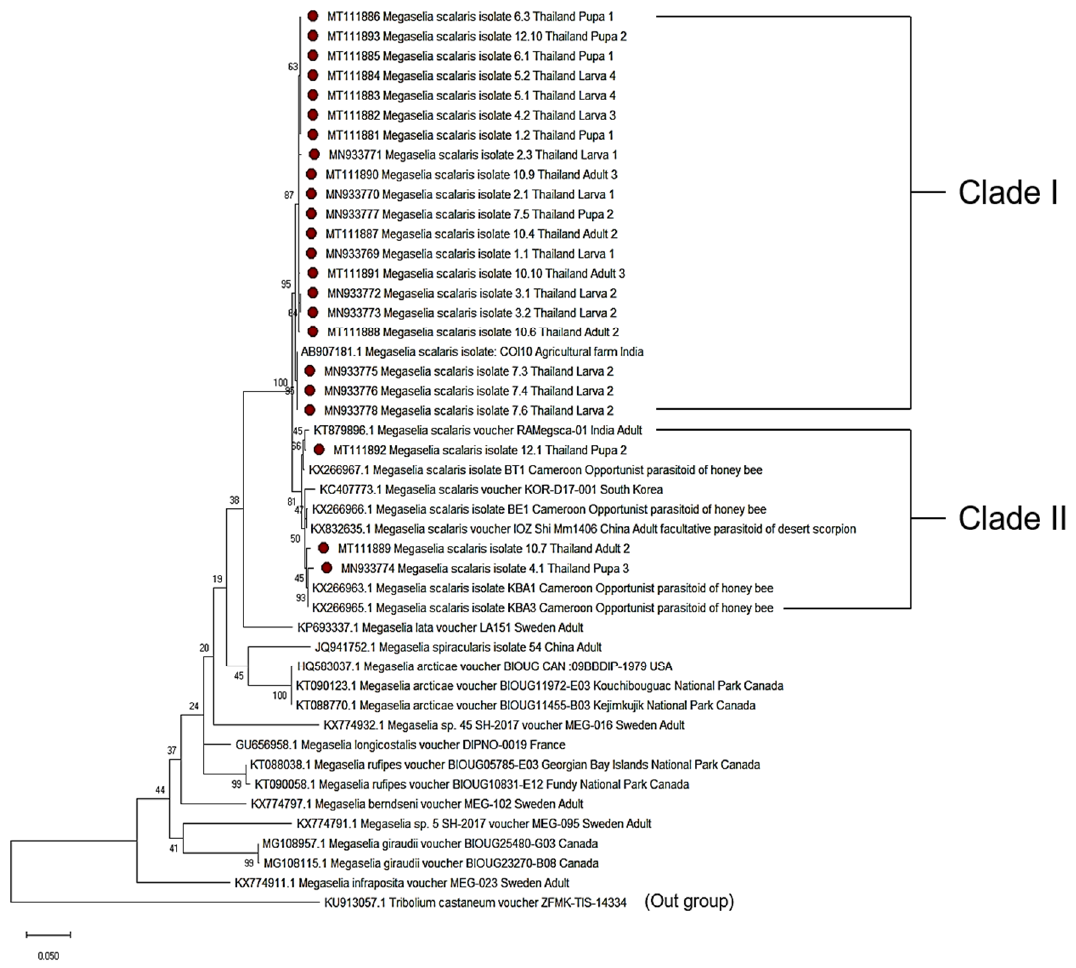
Figure 2. Phylogenetic tree of parasitic Diptera constructed from partial c oxidase I (COI) sequences. The maximum likelihood method was based on the general time reversible model and 1000 bootstrap replications. The sequences from this study, indicated in red, were compared with the reference sequences obtained from GenBank.